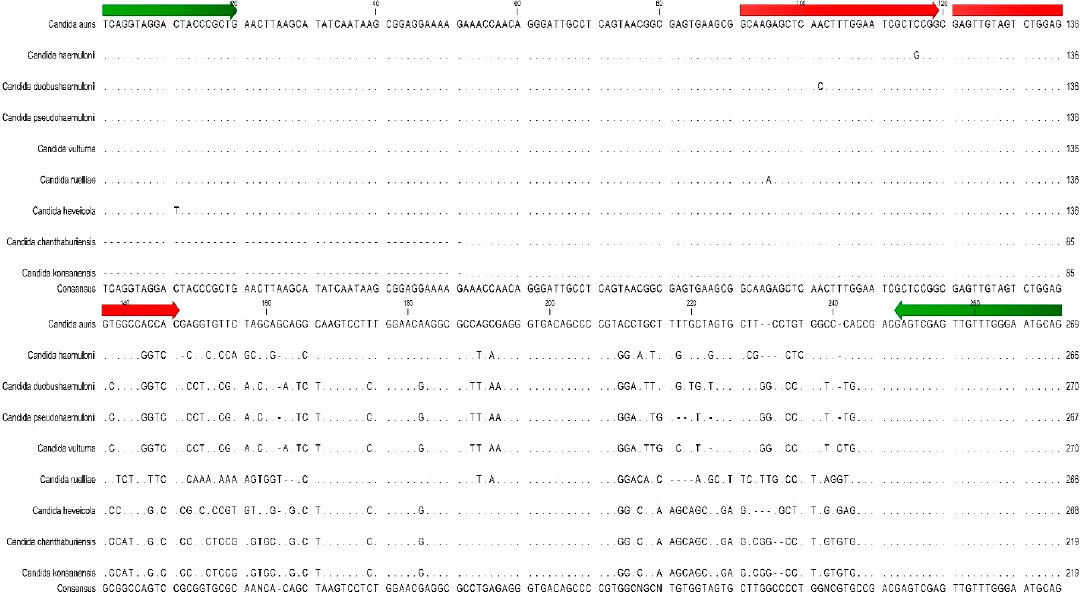
Figure 3. Sequence alignment of C. auris ITS target region with 8 closely related Candida species. Green arrows indicate the position of the PCR assay primers. Red arrows indicate the position of the PCR assay reporter probes.